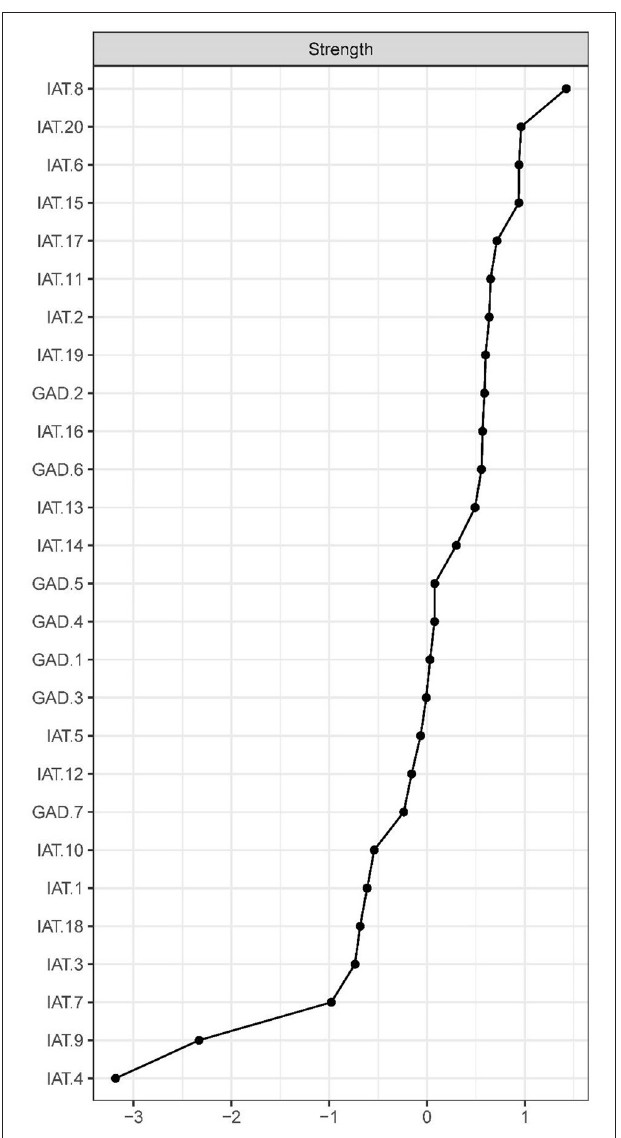
FIGURE 2 | Centrality indices of Internet addiction, shown as standardized values z